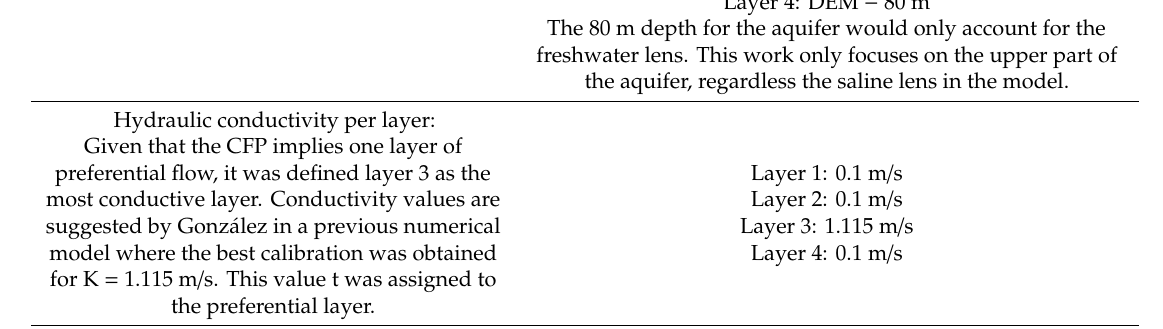
Table A1. Initial parameters used to run de model before calibration. Parameter or Package Values